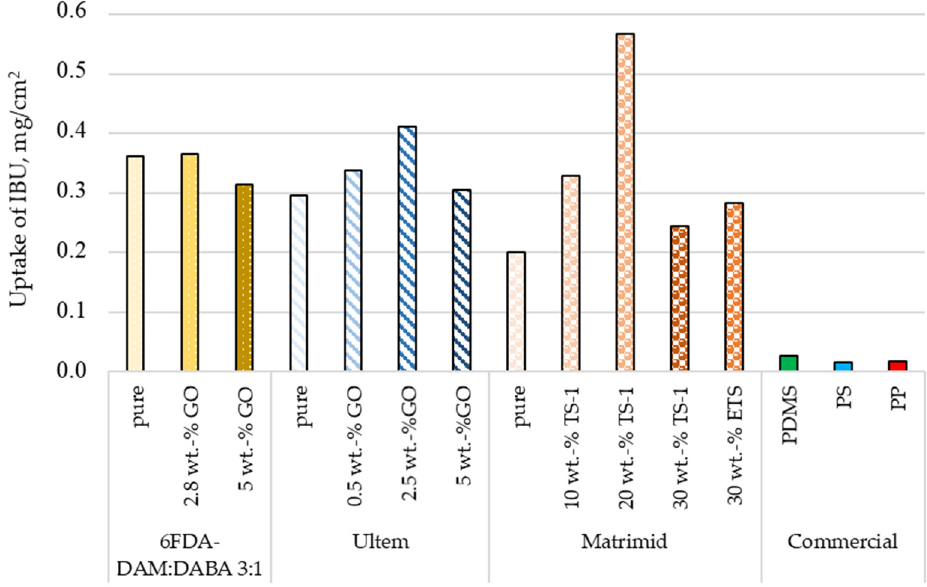
Figure 8. The maximum uptake of IBU from water solution per cm 2 of tested membranes during sorption experiments.